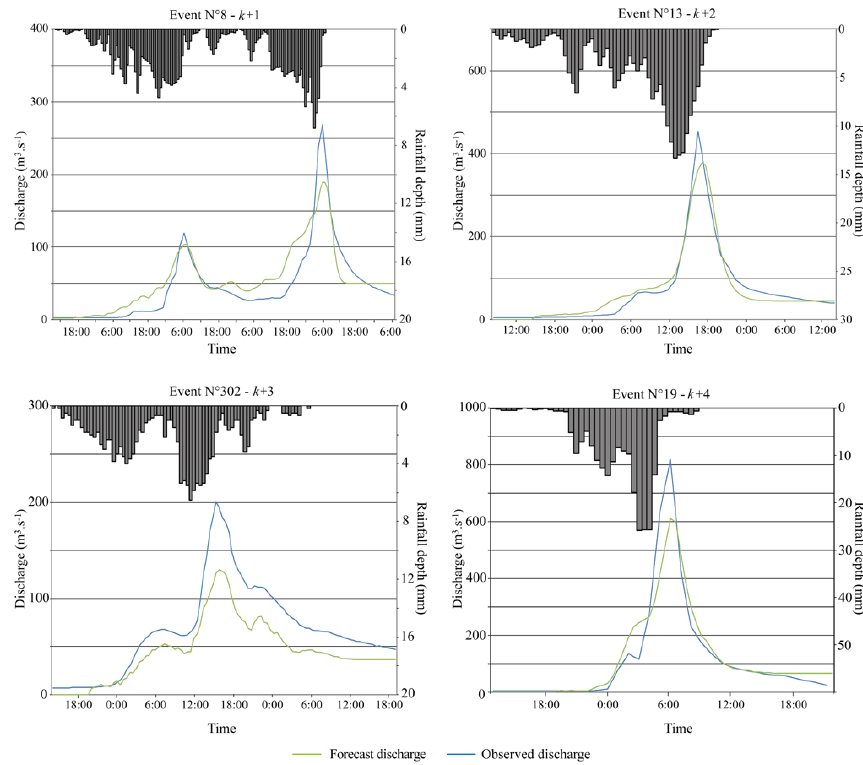
Fig. 9. Forecast and observed discharges for the four tested events with the recurrent model (the forecast lead times are indicated).